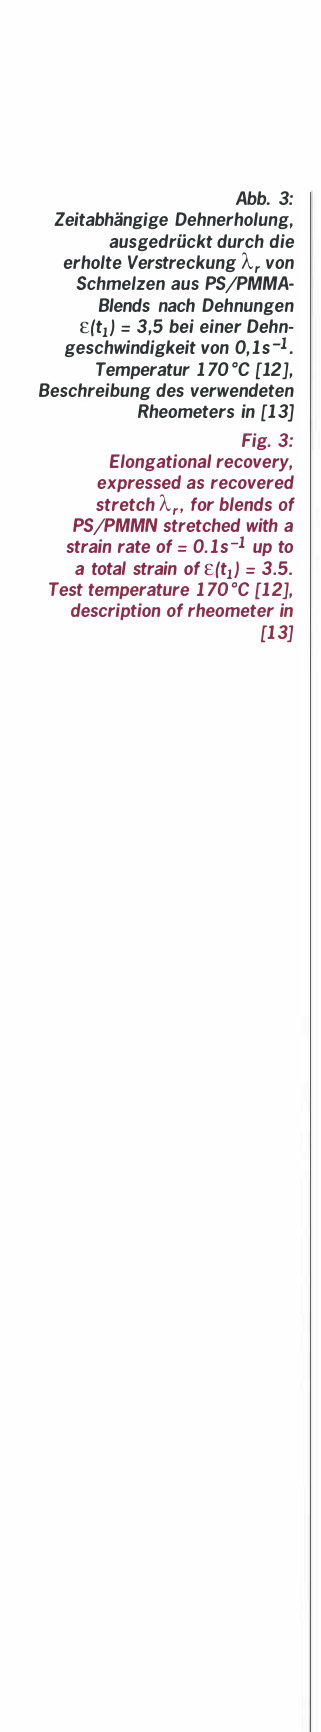
Schematic diagram of the elongational rheometer equipped with metal belts for clamping the polymer melt